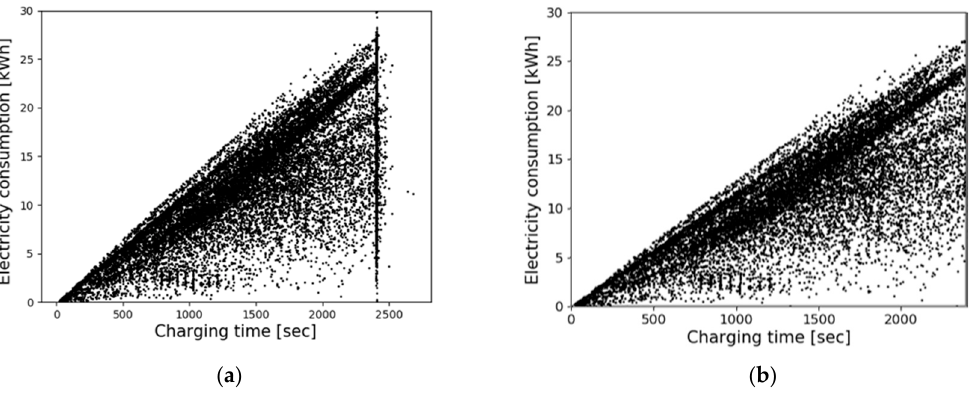
Figure 3. Actual electricity consumption distribution of a fast charger according to charging time (units: charging time (sec), electricity consumption (kWh)). ( a ) before filtering, ( b ) after filtering.